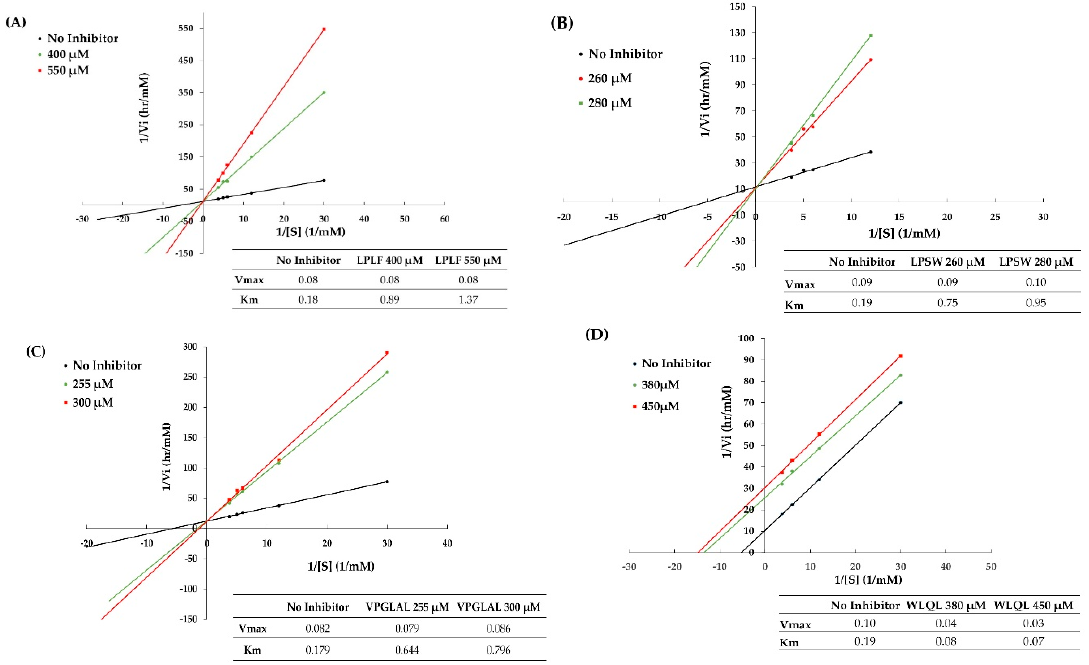
Figure 6. Lineweaver–Burk double reciprocal plots for dipeptidyl peptidase IV (DPP-IV) inhibition with ( A ) LPLF (competitive), ( B ) LPSW (competitive), ( C ) VPGLAL (competitive), and ( D ) WLQL (uncompetitive) were determined at concentrations corresponding to their IC 50 .